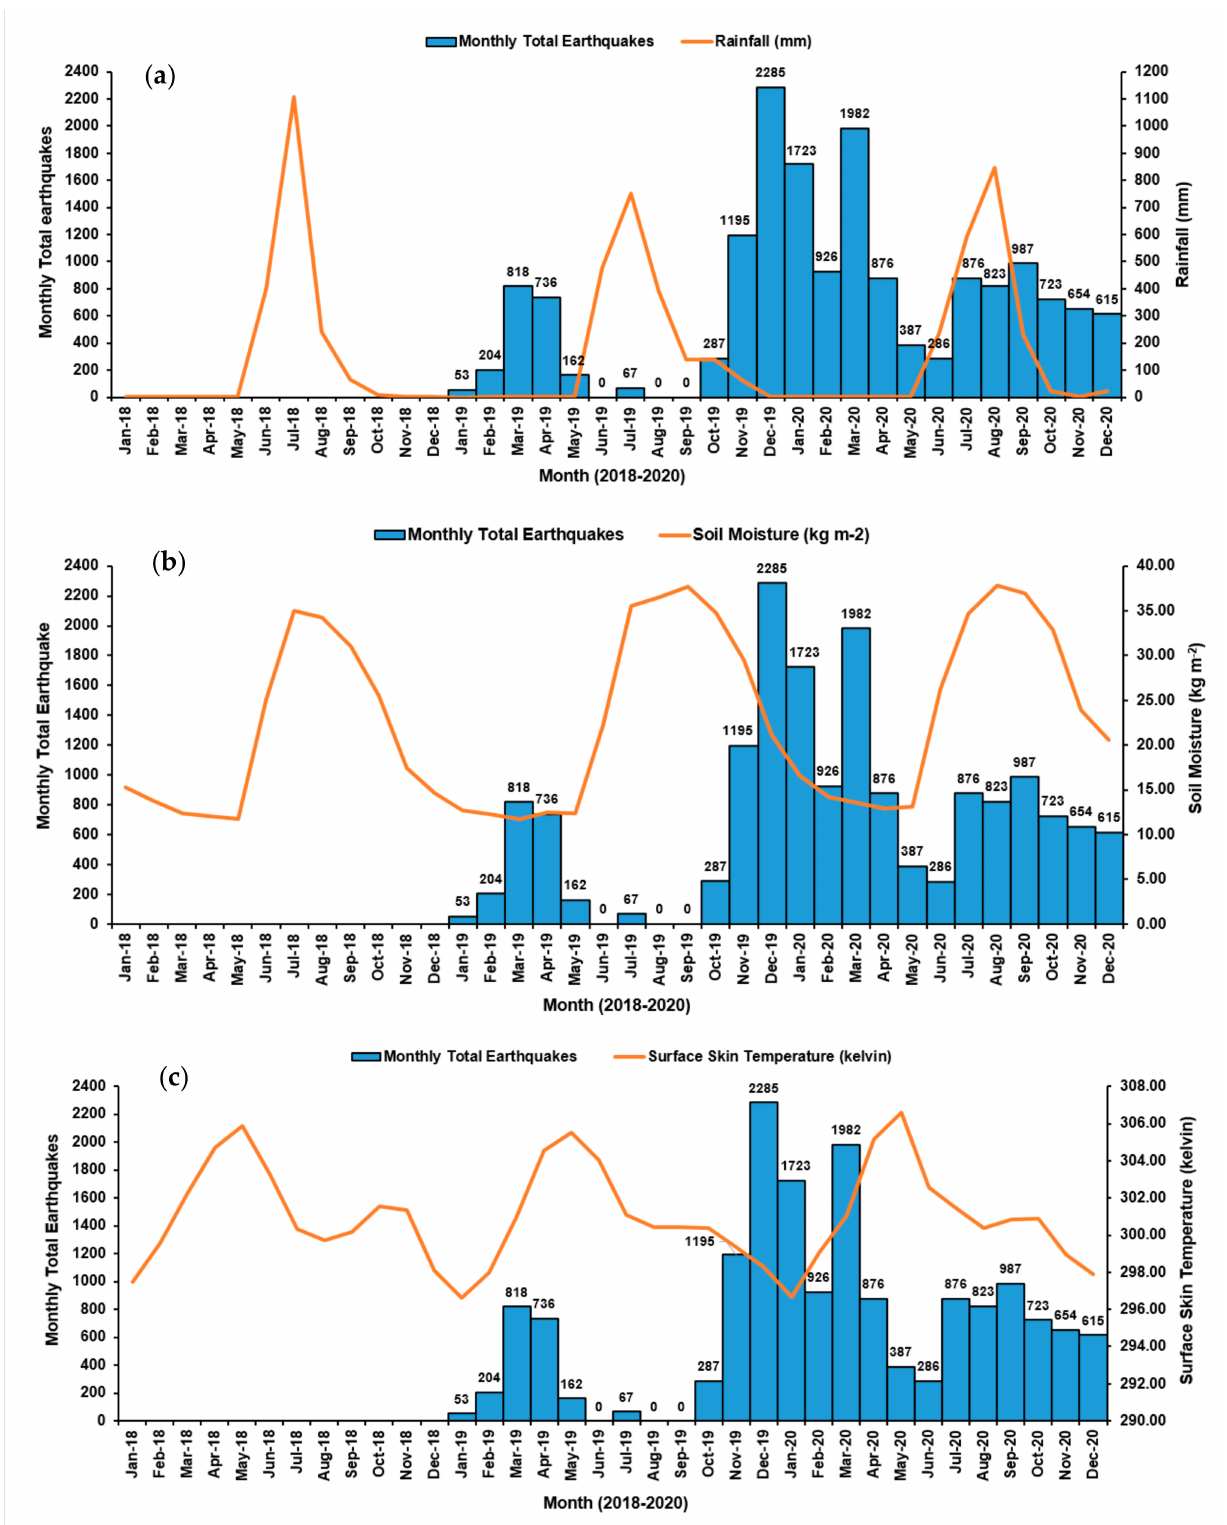
Figure 8. Examining earthquakes association with the meteorological and geophysical parameters; ( a ) monthly total earthquakes with monthly rainfall distribution; ( b ) associations examining monthly earthquakes with soil moisture content at 0–10 cm underground, and ( c ) associations examining with monthly earthquakes total with surface skin